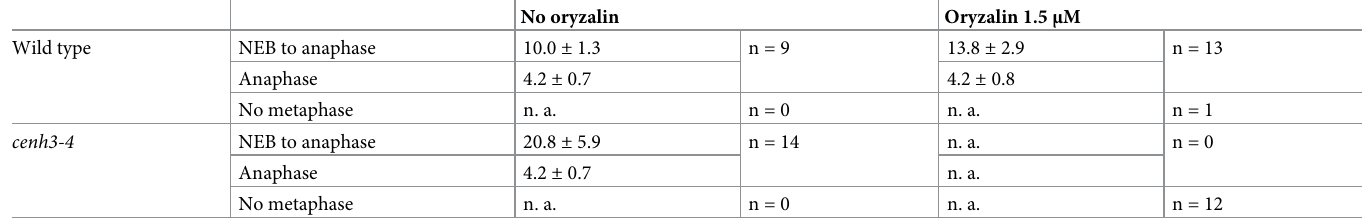
Table 1. Duration of mitotic phases in root cells. NEB was defined as a time point when nuclei lost round shape (Fig 9C). None of the examined cells in cenh3-4 roots treated with oryzalin that entered the mitosis formed a metaphase plate (n =